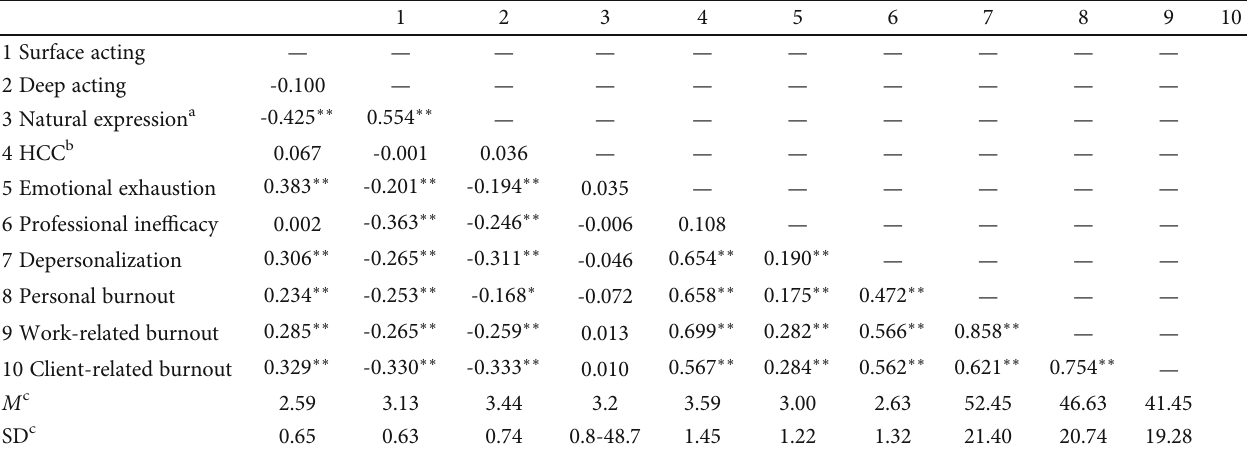
Table 1: Means, standard deviations, and coe ffi cients of correlations for the study variables ( n = 229